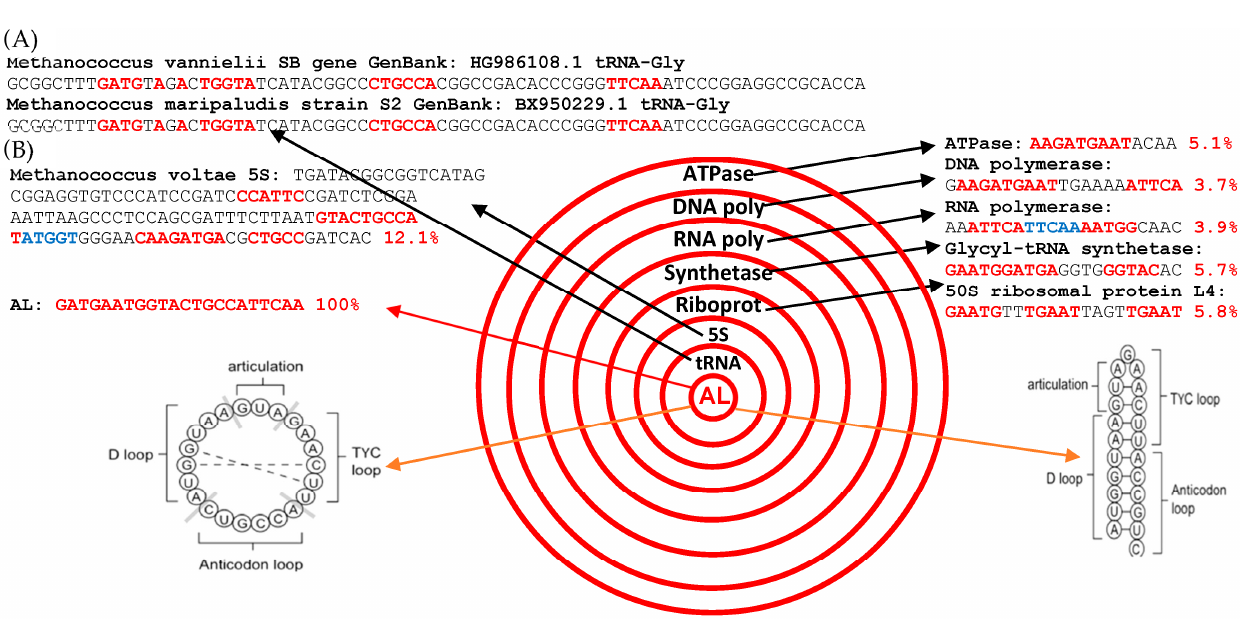
Figure 3. ( A ) Primary structure of Gly-tRNA in Methanococcus vanniellii or Maripaludis voltae showing the consecutive subsequences of the AL-ring inside the successive tRNA loops. ( B ) AL-proximity of the main RNA or protein molecules participating to the ribosomal translation in Methanococcus voltae . The expected percentage is 2.15 ± 0.75% (95%-confidence interval) for a 1000-nt length sequence (cf. Supplementary Materials). The pentamers are indicated in red or in blue in presence of overlapping.